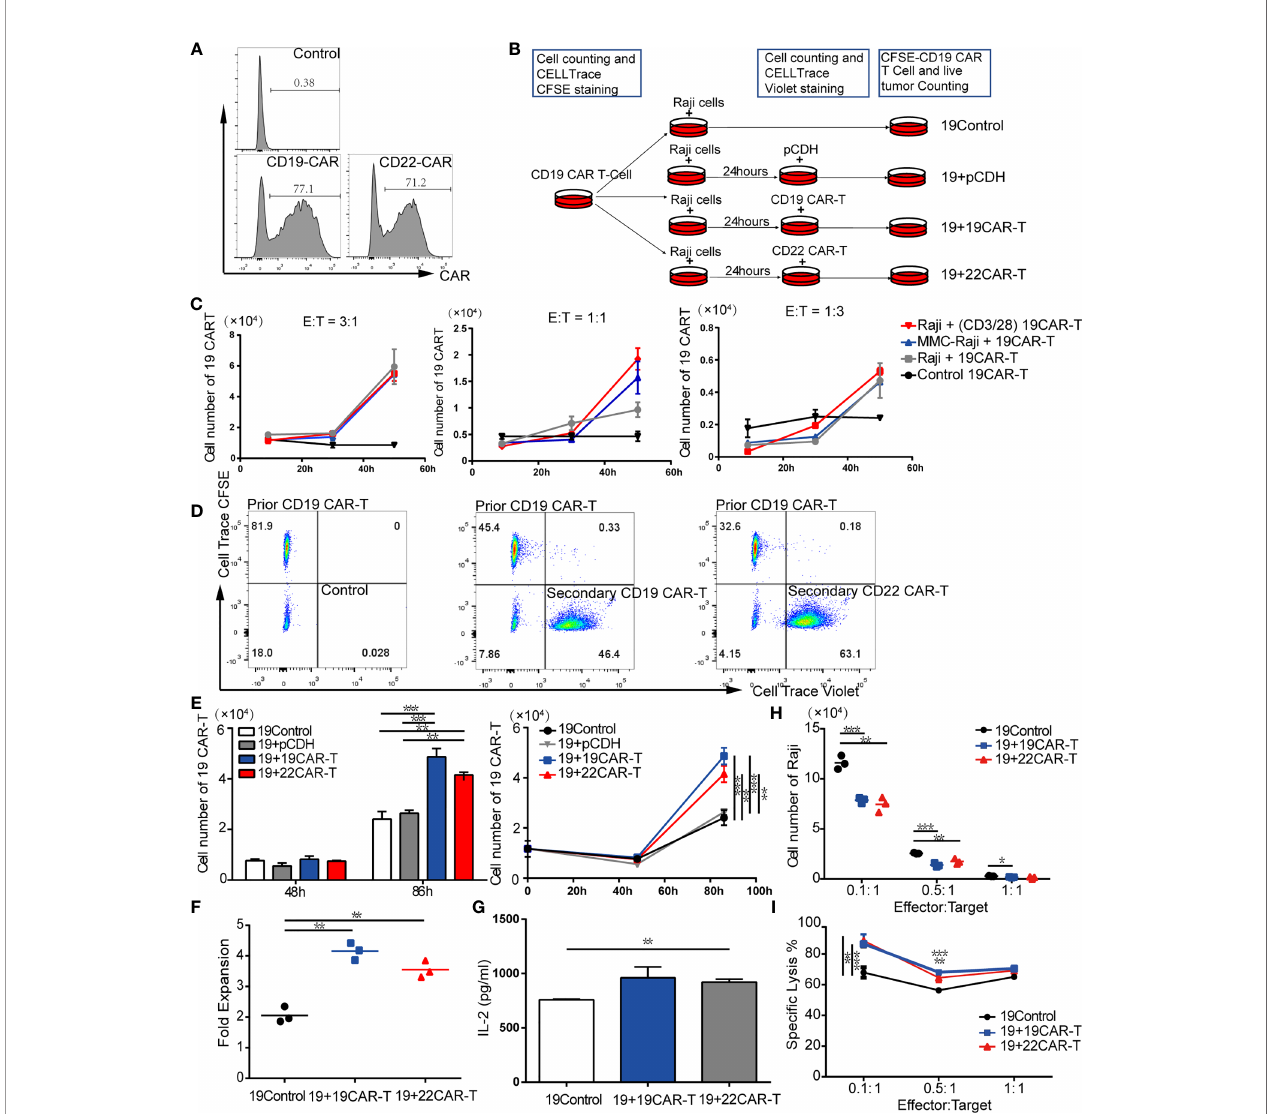
FIGURE 1 | Sequential administration of CAR-T cells ampli fi ed the prior CD19 CAR-T cells in vitro. (A) Transduction ef fi ciency of CD19 and CD22 CAR-T. (B) Experimental procedure of expansion models in vitro . (C) Expansion curves at three ratios of effector-to-target (E:T) under different treatment. (D) Flow cytometry (FCM) analysis of prior CD19 CAR-T cells labeled CellTrace CFSE and subsequent 19 CAR-T cells or 22 CAR-T cells labeled CellTrace Violet. (E) Absolute cell number (upper left panel), expansion curves (upper right panel) at several time points. At 86 h fold expansion (F) of prior CD19 CAR-T cells, and IL-2 level (G) were measured. (H) live tumor cells counting after co-culture on 96 h and percentage of lysis (F) at 1:1, 1:5 and 1:10 ratio of E:T. *P < 0.05, **P < 0.01, ***P < 0.001 compared with the control group. Standard error means (SEM) are indicated as error